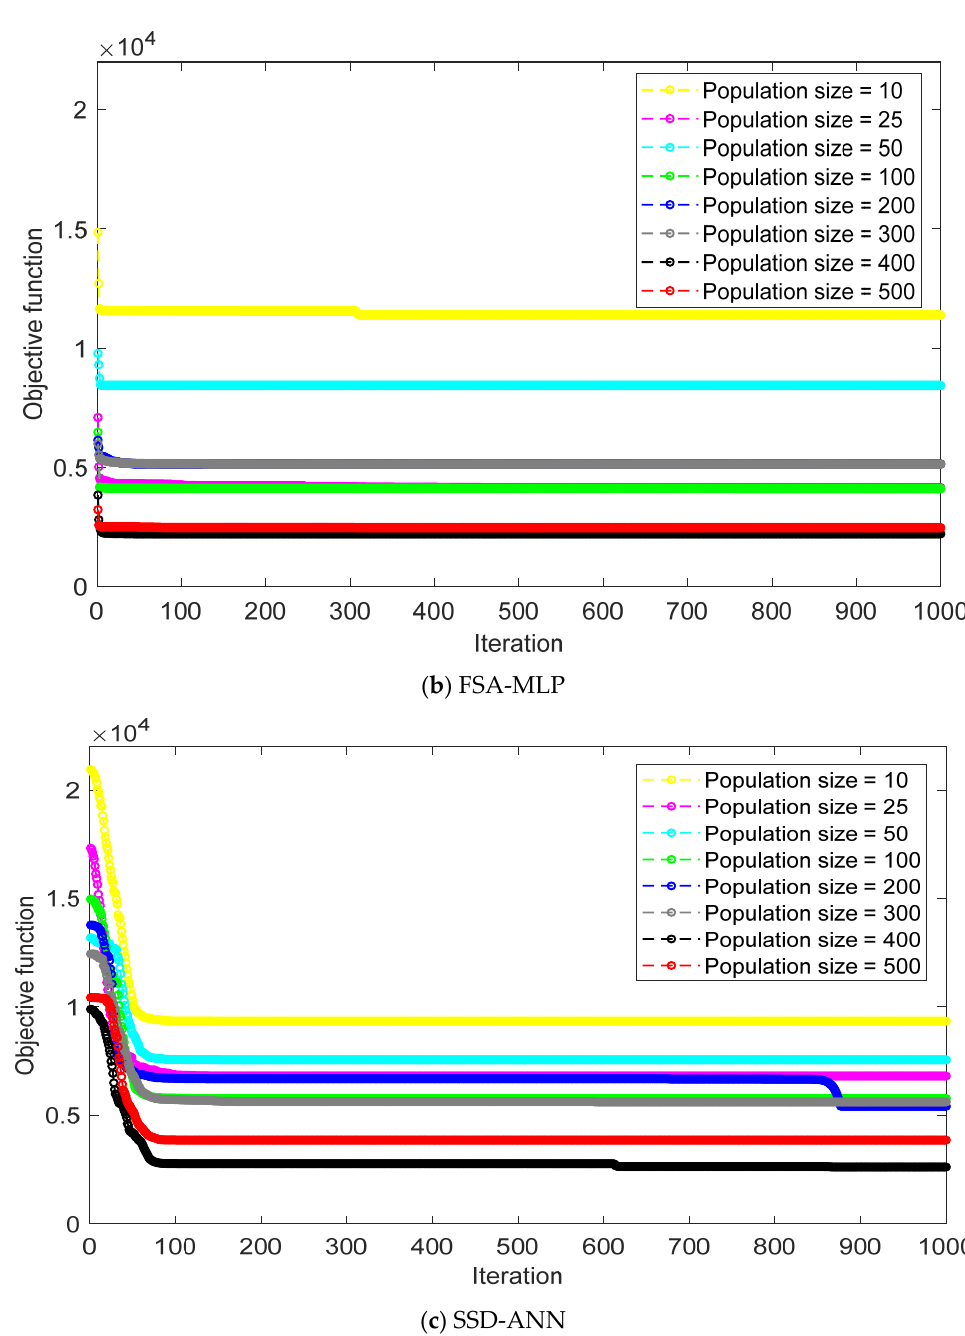
Figure 2. Optimization curves of the implemented ( a ) SOA-ANN, ( b ) FSA-ANN, and ( c ) SSD-ANN. According to the obtained RMSEs, 790.1621, 2215.2954, and 2614.6768for the